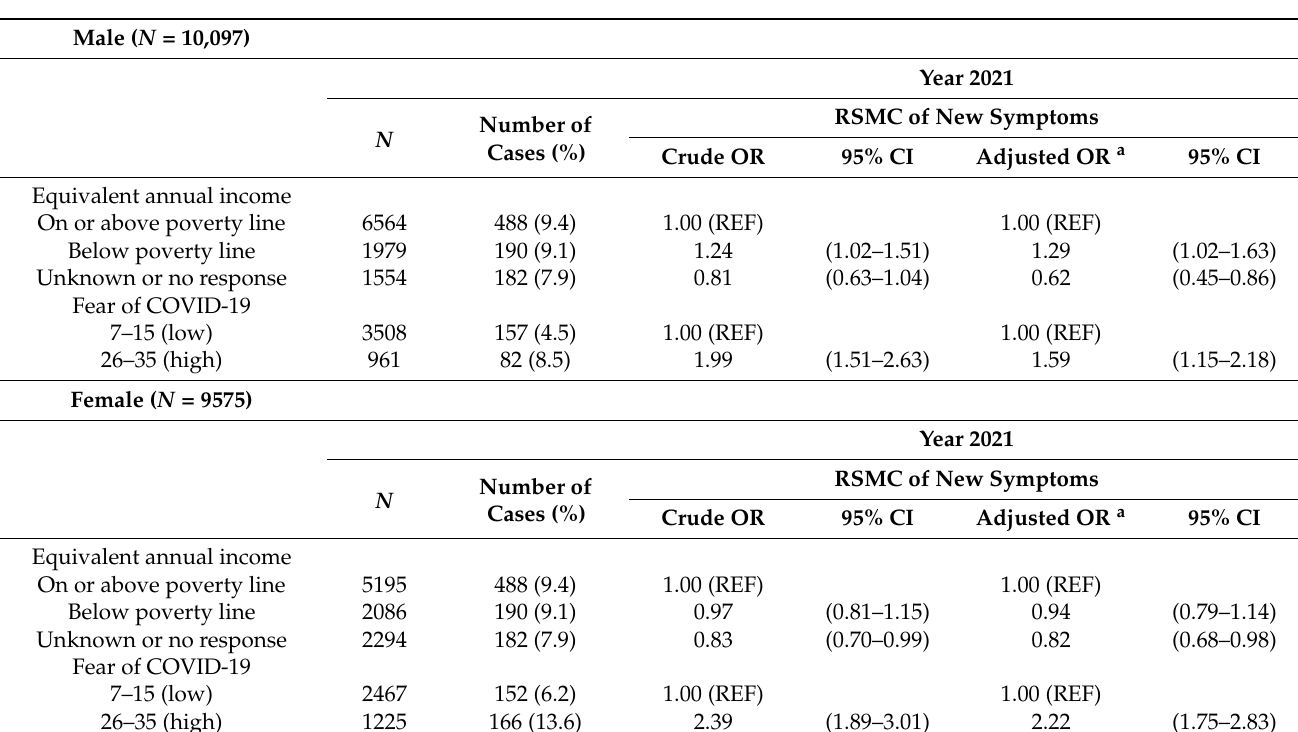
Table 3. Odds ratios (ORs) of household income for refraining from seeking medical care (RSMC) of new